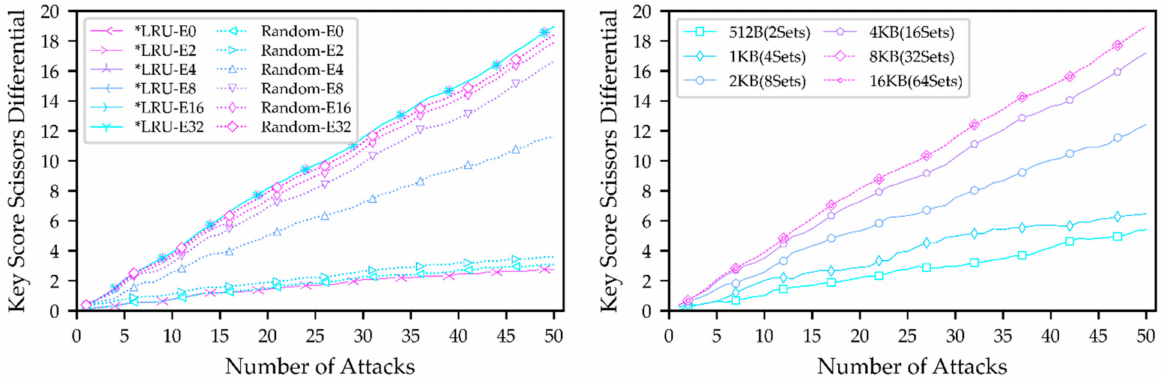
Figure 4. Evaluation of private cache replacement policy ( left ) and private cache capacity ( right